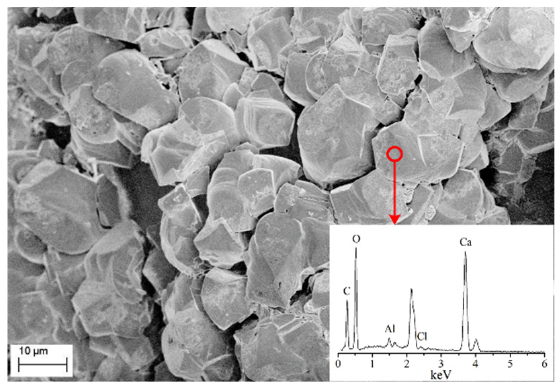
Figure 6. SEM-EDS results of the irregular shape grains.